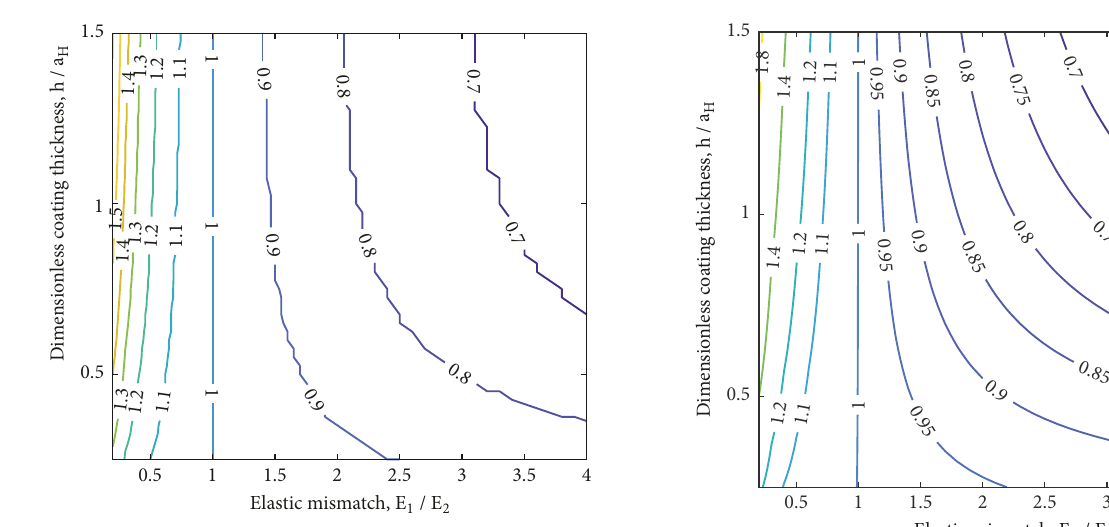
Figure 7: Iso-contours of dimensionless contact radius 𝑎/𝑎 𝐻 .